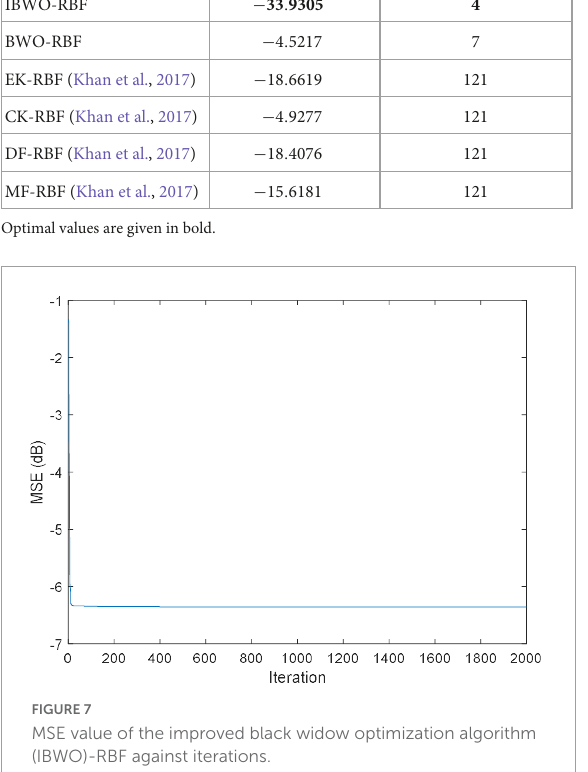
FIGURE7 MSE value of the improved black widow optimization algorithm (IBWO)-RBF against iterations.